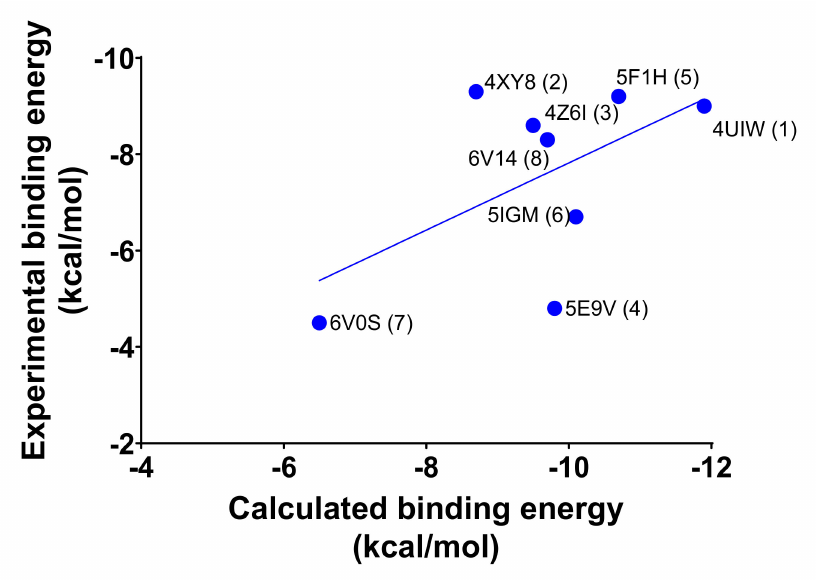
Figure 4. Correlation between the experimental and calculated binding affinities. The values of each complex are labeled